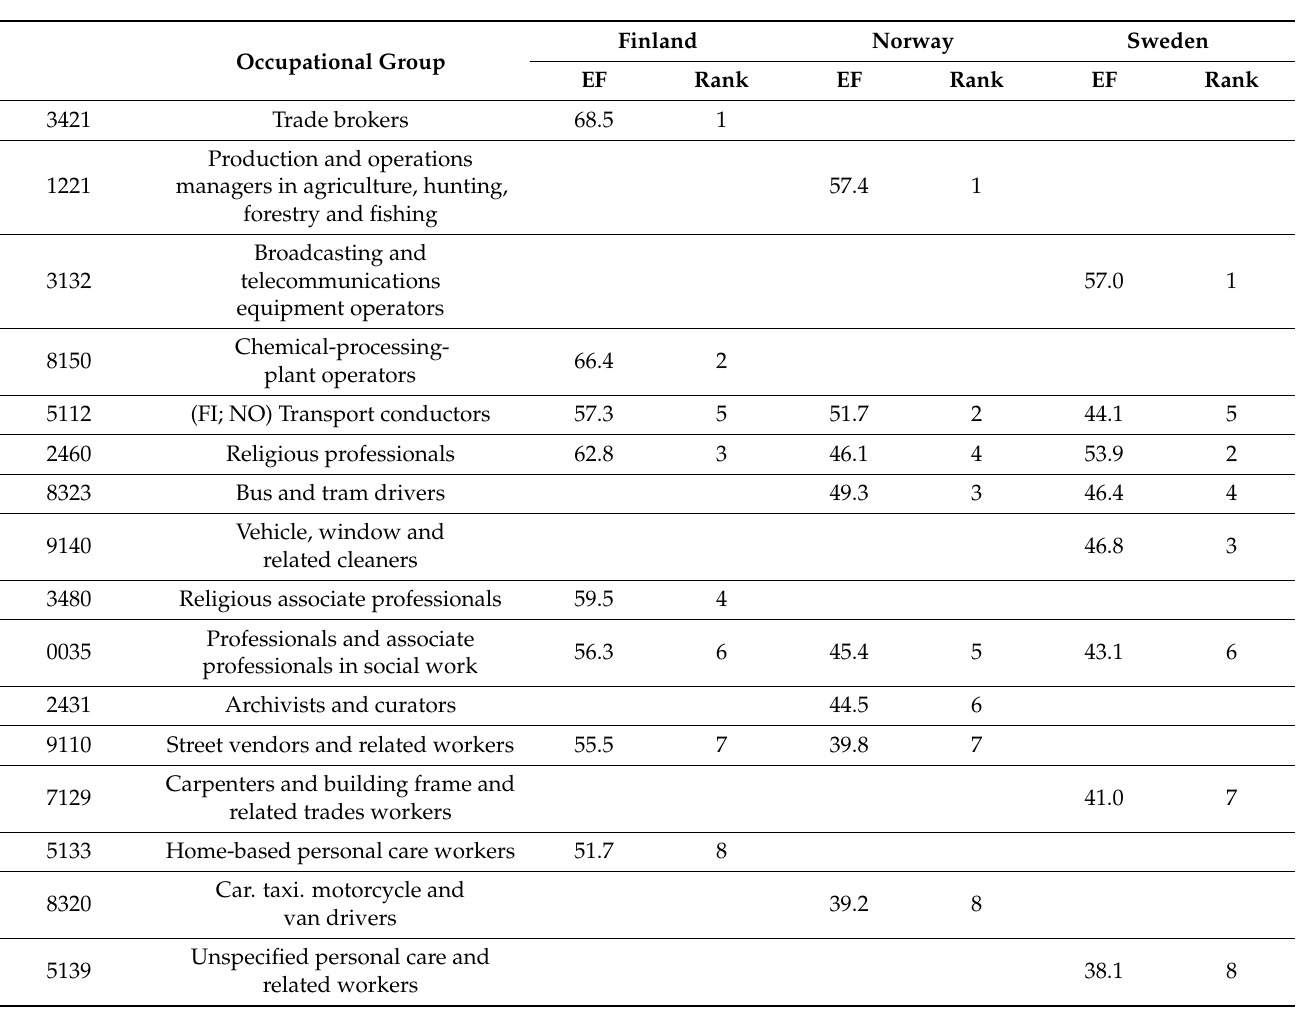
Table 6. Occupational groups with rank 1–10 based on the excess fraction (EF, %) of the